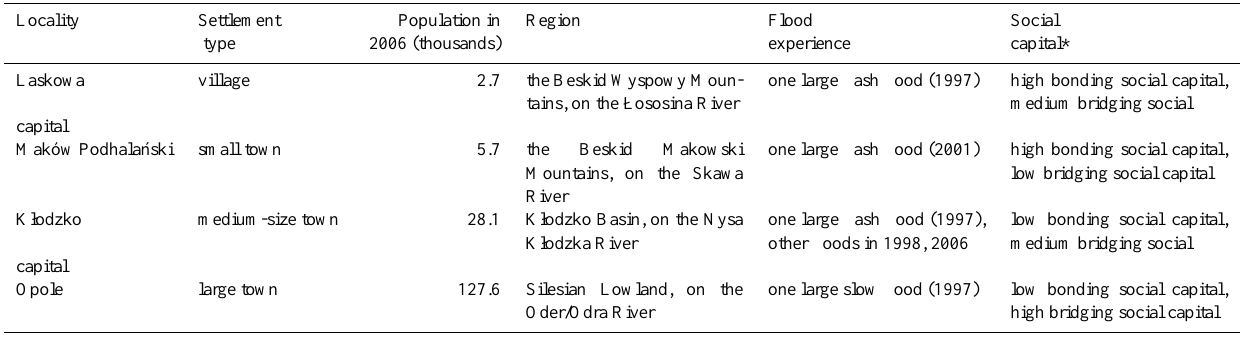
Table 1. Characteristic features of the localities in southern Poland included in the study. Locality